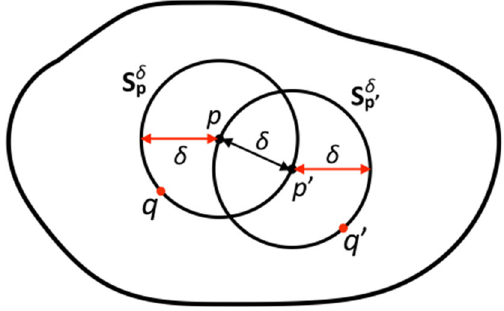
Fig. 1 The local geometric set-up for determining the quantum Ricci curvature consists of two overlapping spheres S δ p and S δ whose centres p and p (cid:4) likewise are a distance δ apart. The average sphere distance (1) is obtained by averaging over the distances between all point pairs ( q , q (cid:4) ) along the two